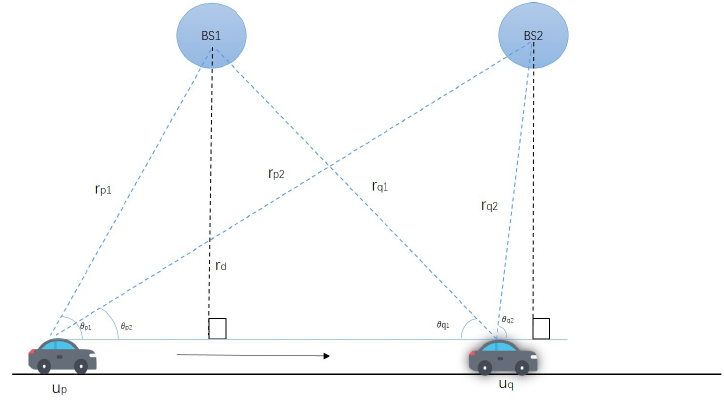
Figure 1. Base station and receiver location